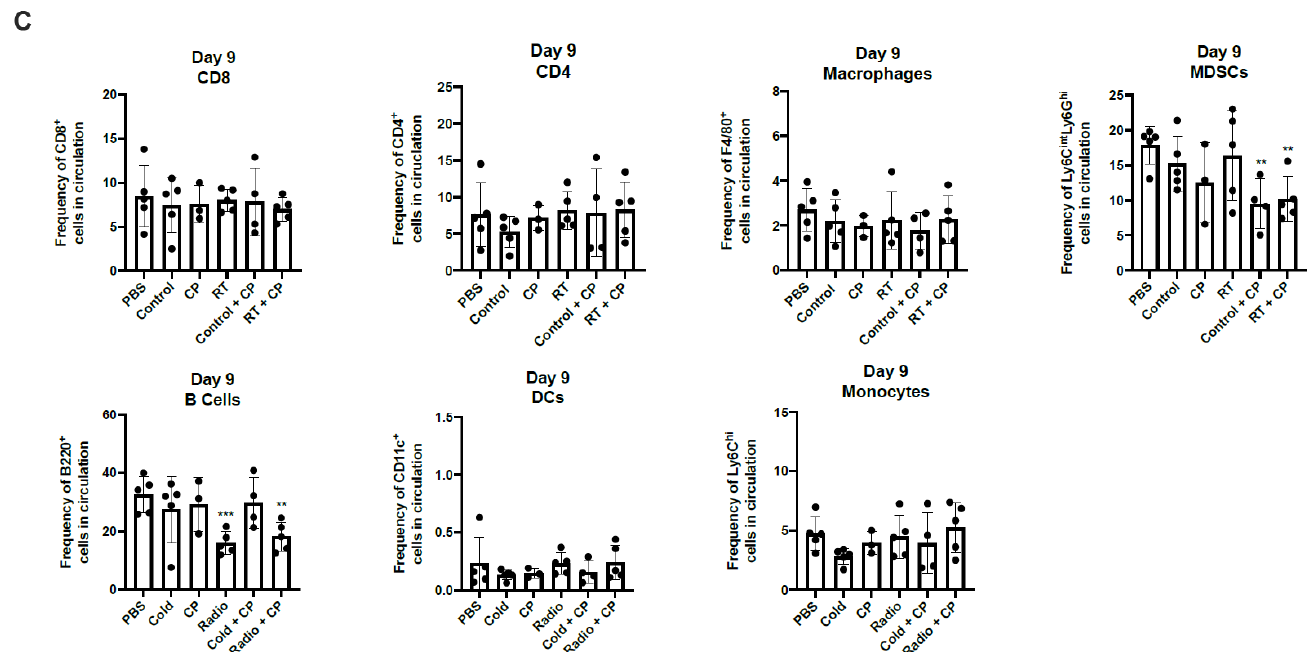
Figure 8. RT + CP decreases immunosuppressive MDSCs and B cells in the peripheral blood. C57/Bl6 mice bearing E0771 tumors were treated with either PBS, Control, CP, RT, Control + CP, or RT + CP. Blood was drawn on days 4 and 9 and analyzed via flow cytometry. ( A ) Representative flow plots showing the gating strategy for CD4 + T cells, CD8 + T cells, F4/80 + macrophages, Ly6C hi Ly6G - monocytes, Ly6G hi Ly6C int MDSCs, B220 + B cells, and CD11c + DCs. ( B ) Bar plots showing the frequency of cells in circulation on day 4. ( C ) Bar plots showing the frequency of cells in circulation on day 9. * p < 0.05; ** p < 0.01; *** p < 0.001; **** p < 0.0001.